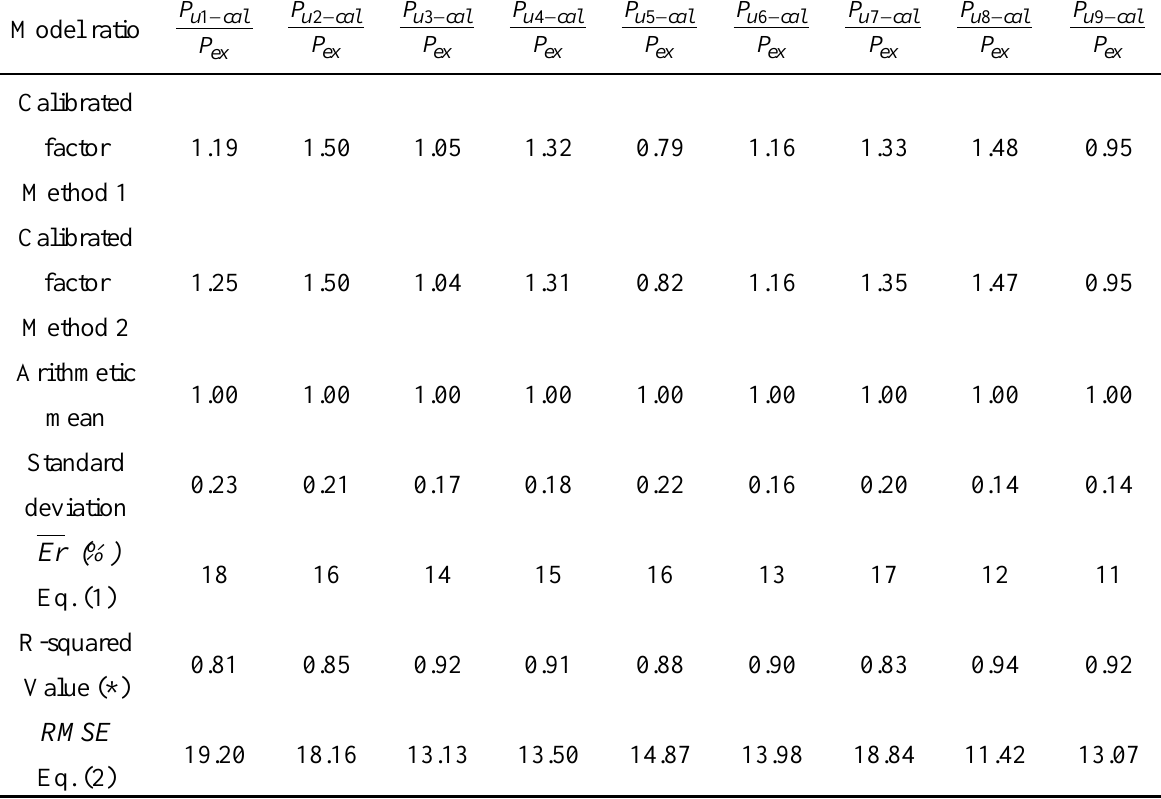
Table 3. Statistical parameters of the calibrated models (using method